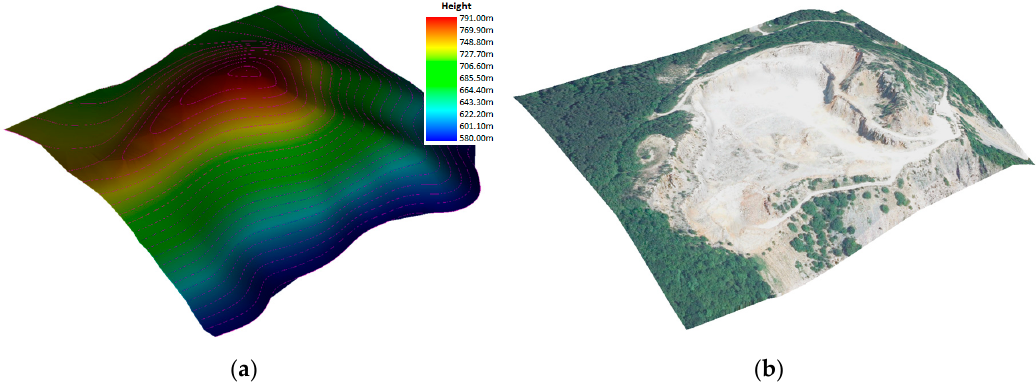
Figure 11. Comparison of visualization of two created models of the open-pit mine. ( a ) Model from topographic map (year 1980); ( b ) Model from geodetic measurement with orthophoto (present time).